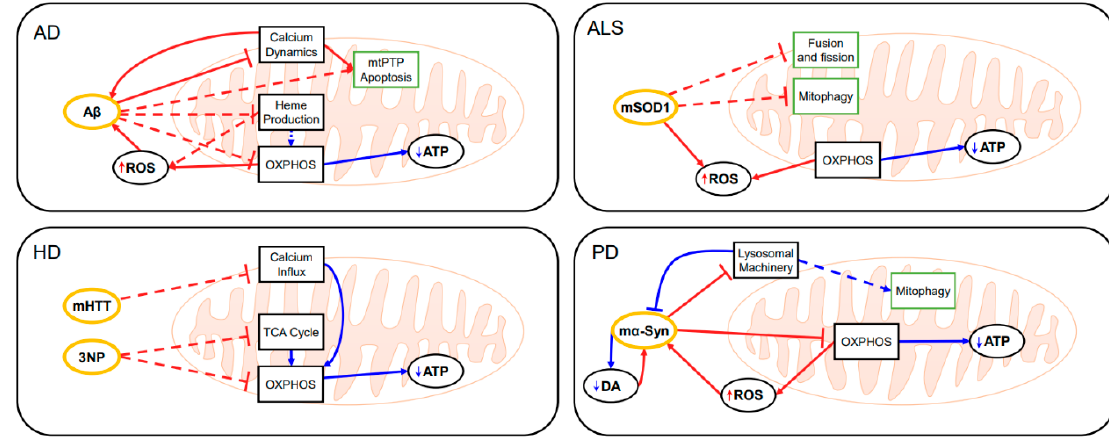
Figure 8. Mitochondrial mechanisms of major neurodegenerative diseases including Alzheimer’s disease (AD), Parkinson’s disease (PD), Huntington’s disease (HD), and amyotrophic lateral sclerosis (ALS). Ovals and rectangles are molecules and pathways, respectively. Sharp/blunt arrows represent positive/negative interactions. Interactions that are enhanced in the disease condition are colored in blue, while the diminished are colored in red. Pathways in a single mitochondrion scale are colored in black and pathways in a population scale are colored in green. Interactions that have not been computationally modeled are represented in dashed lines. A β , amyloid-beta; ROS, reactive oxygen species; OXPHOS, oxidative phosphorylation; mtPTP, mitochondrial permeability transition pore; m α -Syn, mutant α -synuclein; DA, dopamine; TCA, tricarboxylic acid; mHTT, mutant huntingtin; 3NP, 3-nitropropionic acid; mSOD1, mutant superoxide dismutase 1.